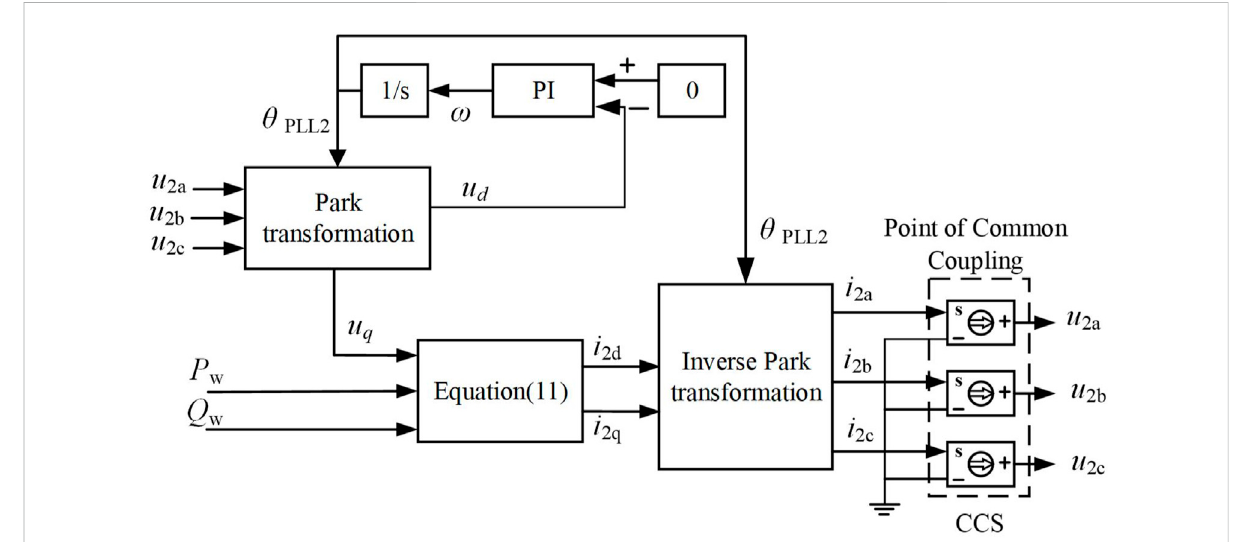
FIGURE 5 Interface modulestructureofthesimpli fi edmodeland powergridestablishestheelectricalinterfacebetweenthesimpli fi edmodel ofthewind farm and thegrid, allowing thepower ofthe simpli fi edmodel to betransformedinto three-phase voltage and current for grid-connected